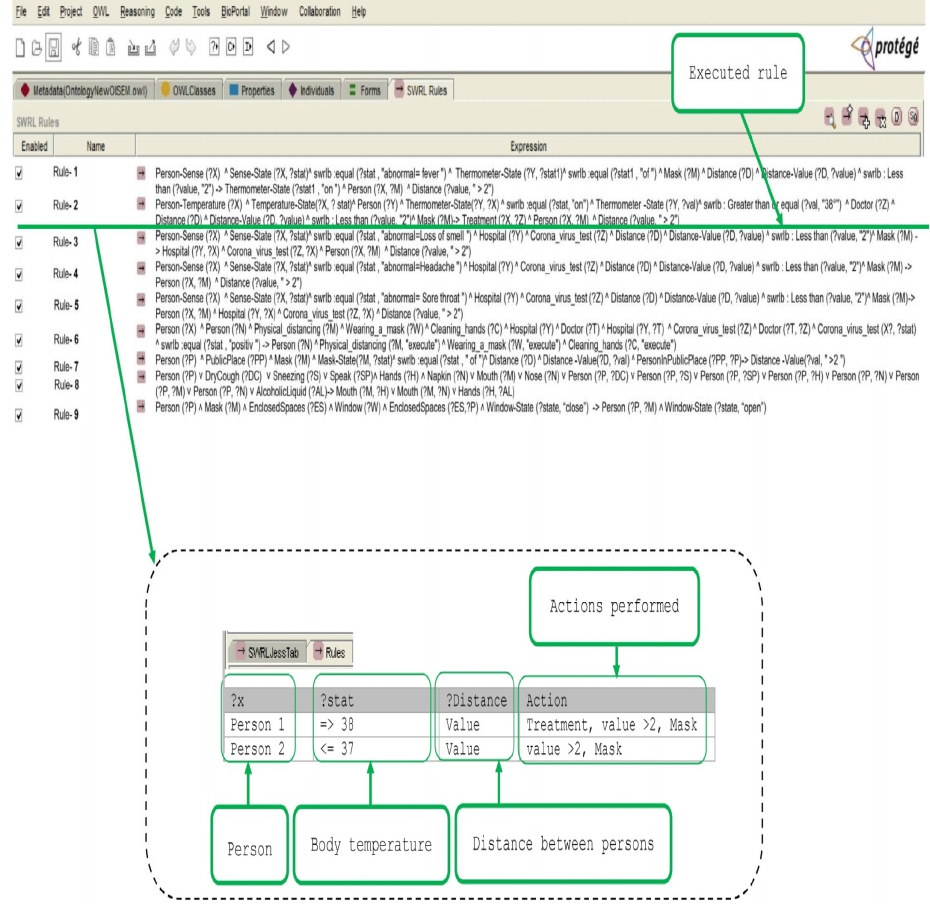
Figure 5. Results of the second scenario.